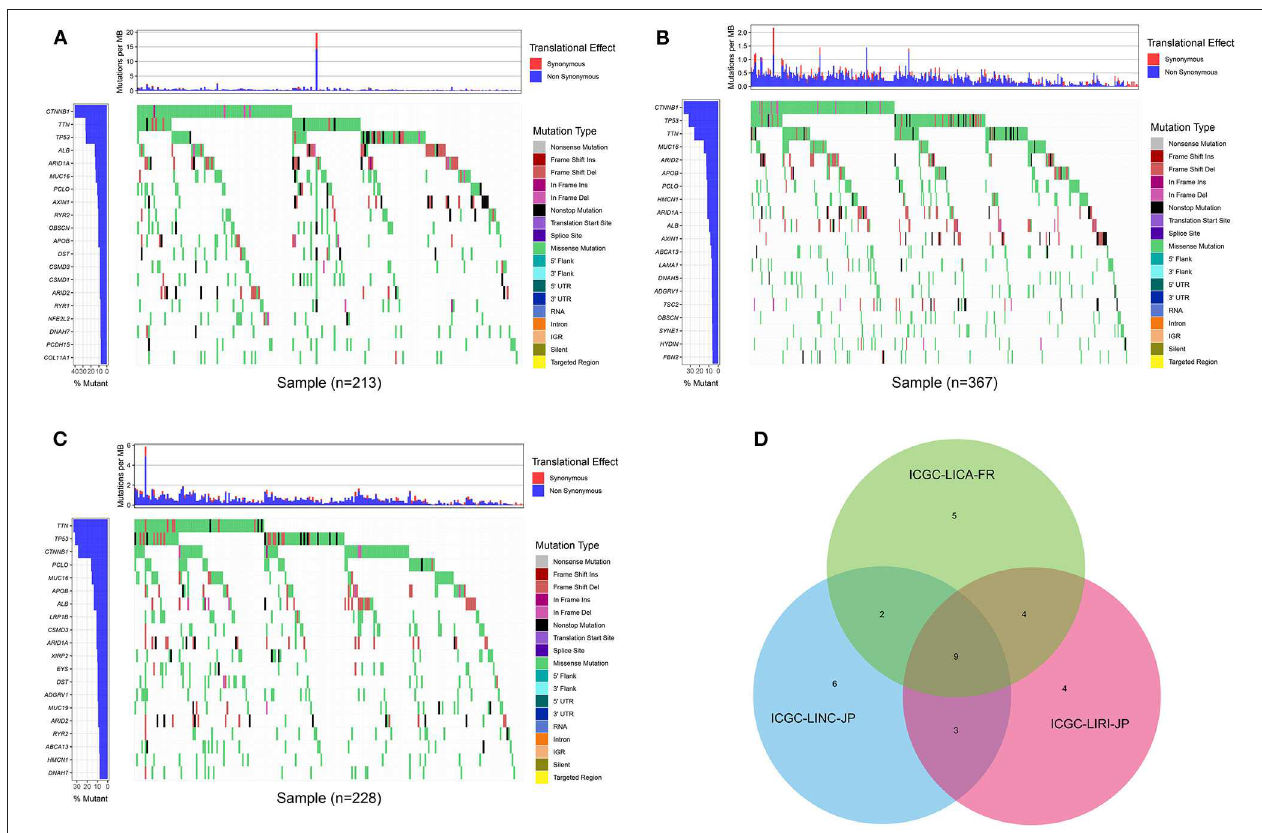
FIGURE 2 | Waterfall plot with the details of gene mutation from three cohorts. (A) The waterfall plot of LICA-FR. (B) The waterfall plot of LINC-JP. (C) The waterfall plot of LIRI-JP. (D) The Venn plot of three